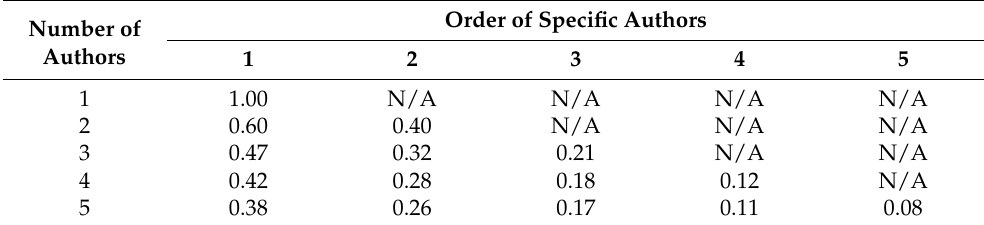
Table 1. Score matrix for papers with multiple authors.